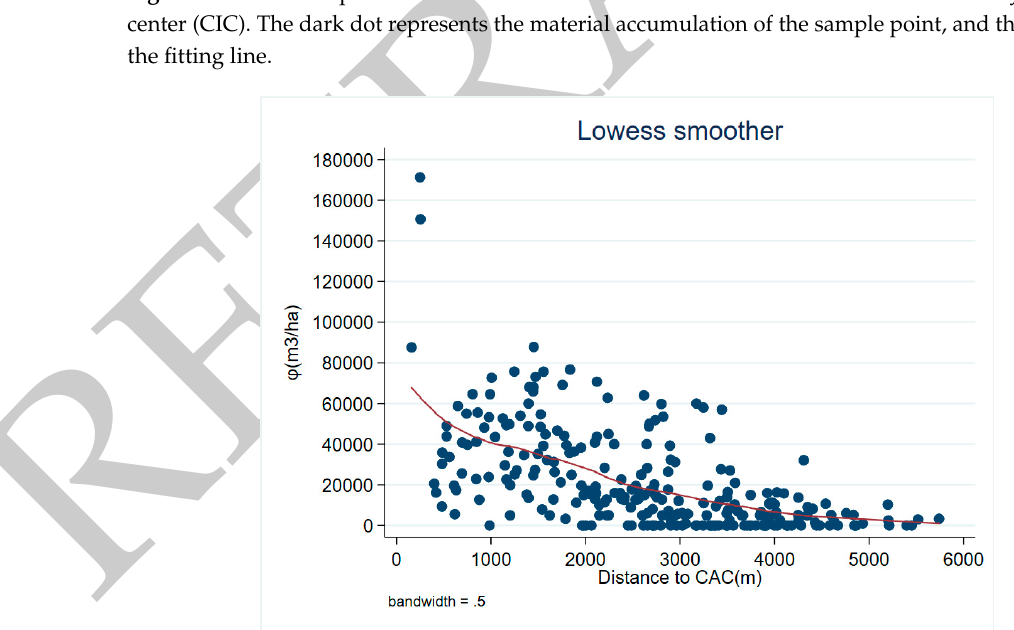
Figure 10. Relationship between cumulative metabolic volume and distance from the city administration center (CAC). The dark dot represents the material accumulation of the sample point, and the red line is the fitting line.